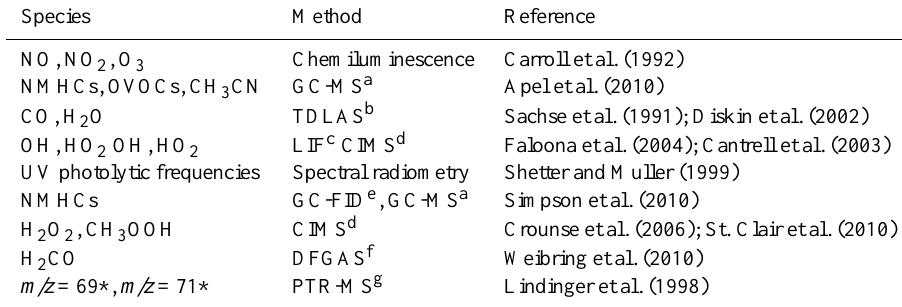
Table 1. Measurements used in this